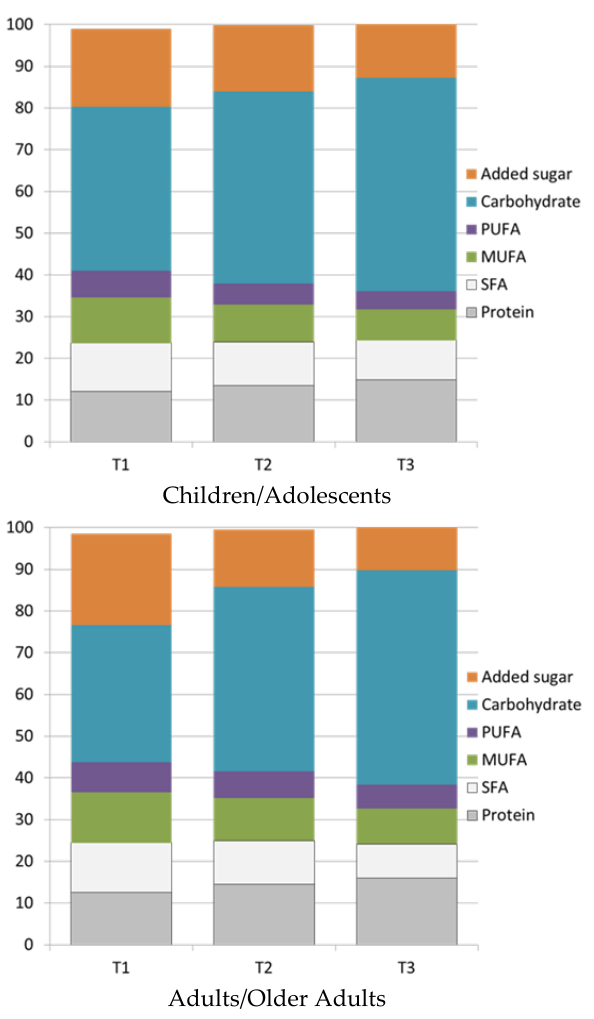
Figure 4. Distribution of breakfast macronutrients by tertiles of NRF9.3 diet quality score. PUFA stands for Polyunsaturated fatty acids, MUFA stands for Monounsaturated fatty acids, SFA stands for Saturated fatty acids.